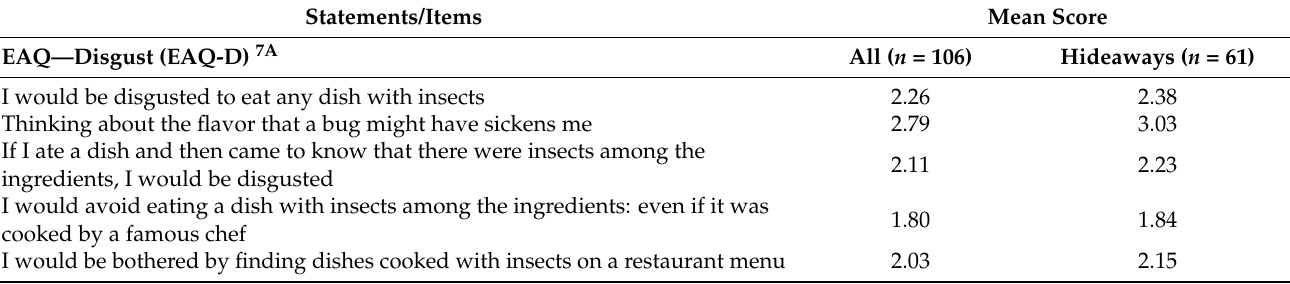
Table 2. Mean scores for the EAQ factors, FNS, belief about consuming insects, purchasing considera- tions, and liking of products containing nonvisible insects for all participants and the Hideaways